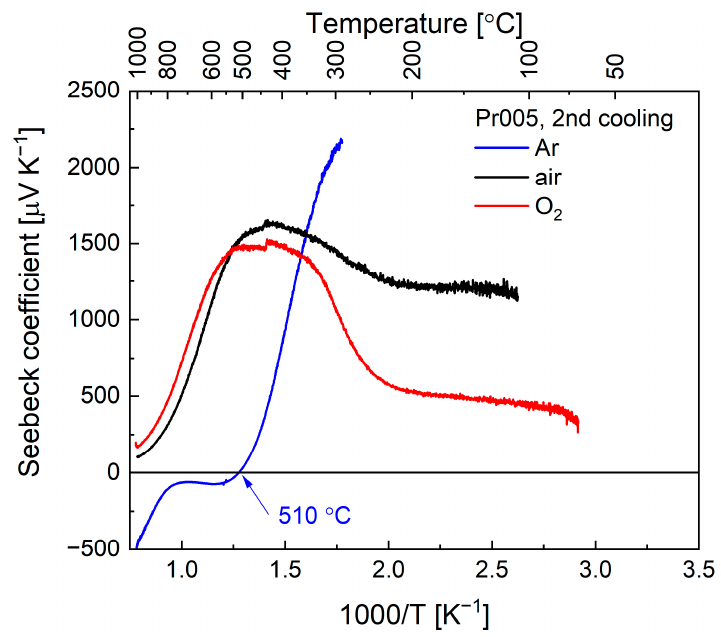
Figure 5. Temperature dependence of Seebeck coefficients of Pr005 in Ar, air and O 2 .